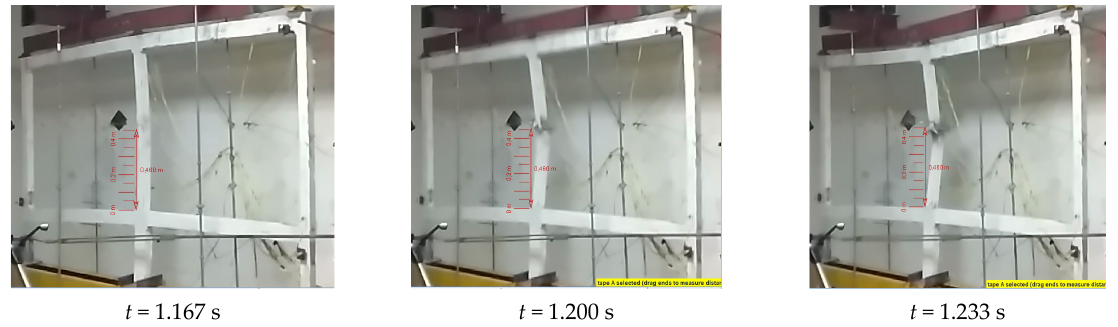
Figure 10. Displacement history of joint C for the X direction ( a ) and displacement history of the middle part of column 2 for the X direction ( b ).